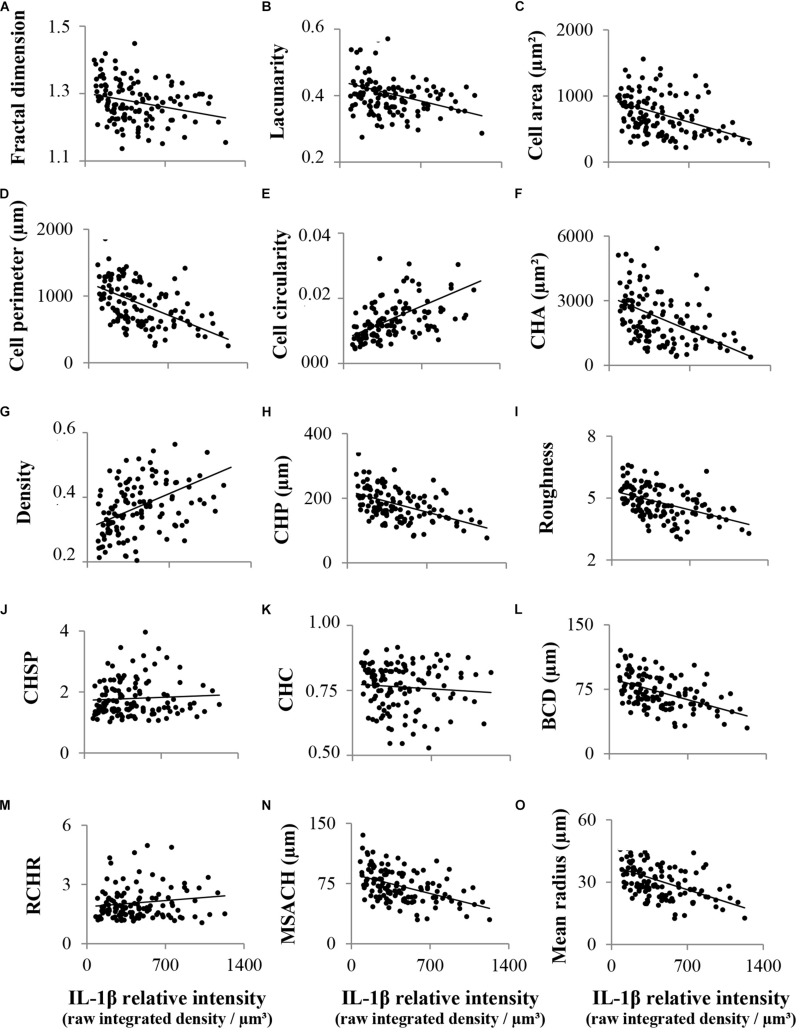
Linear regression analysis between different microglial morphological parameters and IL-1β staining intensity. Fifteen morphological parameters as well as IL-1β relative staining intensity were measured in a total of 150 activated hypothalamic microglial cells. These cells were plotted in scatter graphs, where each morphological parameter was the dependent variable and IL-1β staining intensity (measured as the Raw Integrated Density relative to cellular volume) was the independent variable. The parameters fractal dimension
(A), lacunarity
(B), cell area
(C), cell perimeter
(D), convex hull area (CHA; F), convex hull perimeter (CHP; H), roughness
(I), bounding circle diameter (BCD; L), maximum span across the convex hull (MSACH; N), and the mean radius
(O), showed a negative dependence on IL-1β expression, while the parameters cell circularity
(E) and density
(G) had a positive dependence on the same independent variable. Regression analyses were significant for all these parameters, and correlation coefficients were significantly strong for the straight-line relationship between each paired variables. On the contrary, there was no dependence for the ratio convex hull radii (RCHR; M), the convex hull circularity (CHC, K), and the convex hull span ratio (CHSR; J).